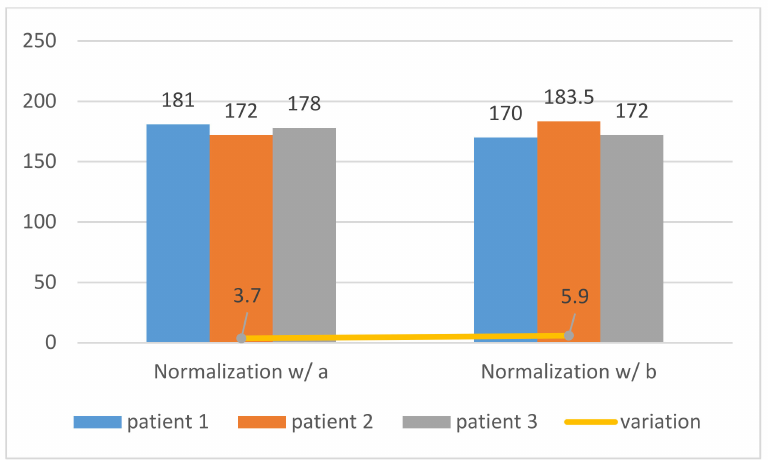
Figure 12. Standard deviation of binarization threshold values between normalized regions. Window width and level were kept constant.